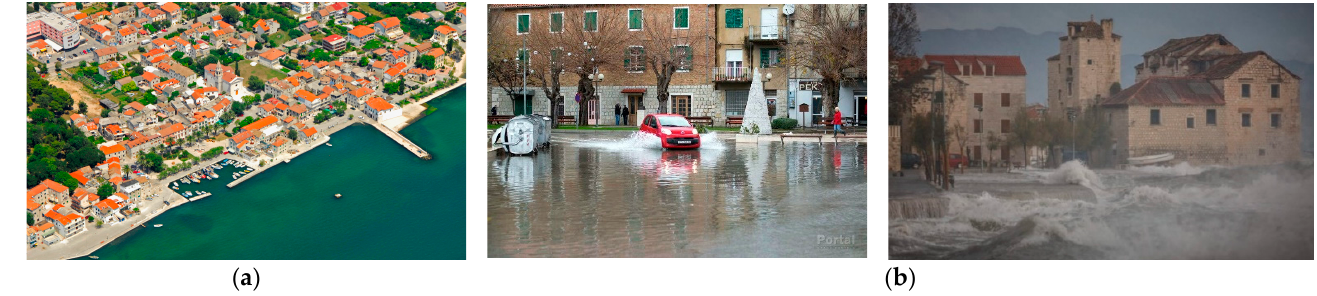
Figure 1. The City of Kaštela: ( a ) Historical center of Kaštel Kambelovac [21]; ( b ) Coastal flooding events in the City of Kaštela [22,23].